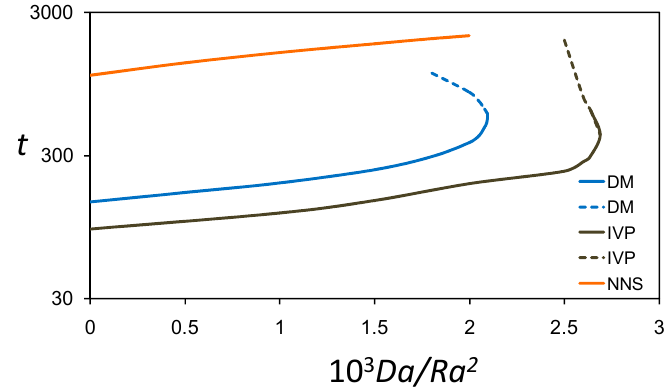
Figure 8. Non-dimensional time for onset and cessation of convection (dimensionless) as a function of Da / Ra 2 for a precipitating reaction, predicted using the dominant mode analysis (DM), initial-value problem approach (IVP), and nonlinear numerical simulations (NNS)